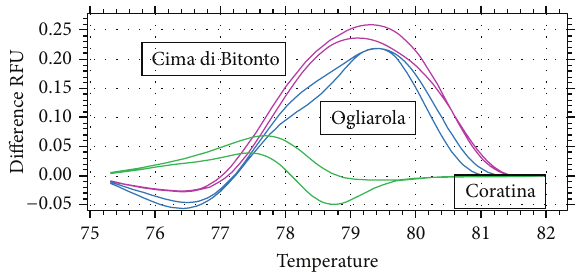
Figure 2: Normalized difference curve of the three cultivars Coratina, Cima di Bitonto, and Ogliarola obtained with the DCA18